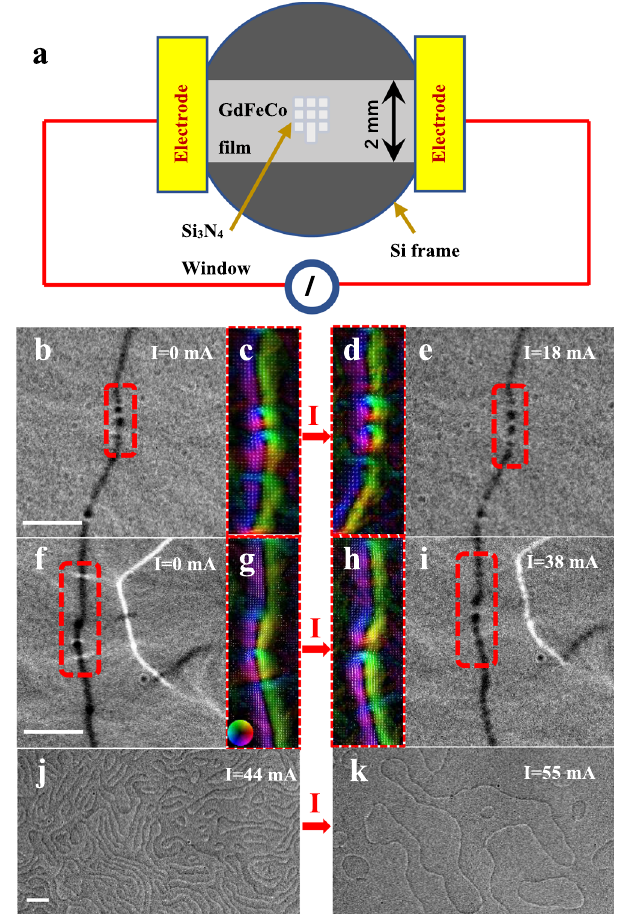
Fig. 4 The meron – skyrmion transformation in the domain wall driven by an electric current at room temperature. a Schematic illustration for electric current manipulation. b – e The disappearance of white contrast of L-TEM images and TIE analysis showing the domain wall transformation from merons to skyrmions under the electric current of 18 mA in Gd 15 + x (Fe 94 Co 6 ) 85 − x ( x = 0.4). f – k The magnetic domain evolution under the electric current of 0, 38, 44, and 55 mA in Gd 15 + x (Fe 94 Co 6 ) 85 − x ( x = 0.7), respectively. The enlarged domain wall textures with in-plane magnetization for selected domain wall regions in c , d , g , h manifest the possible topology transformation. The color wheel for the direction of in- plane magnetization is displayed in the inset. The scale bar is 1 μ